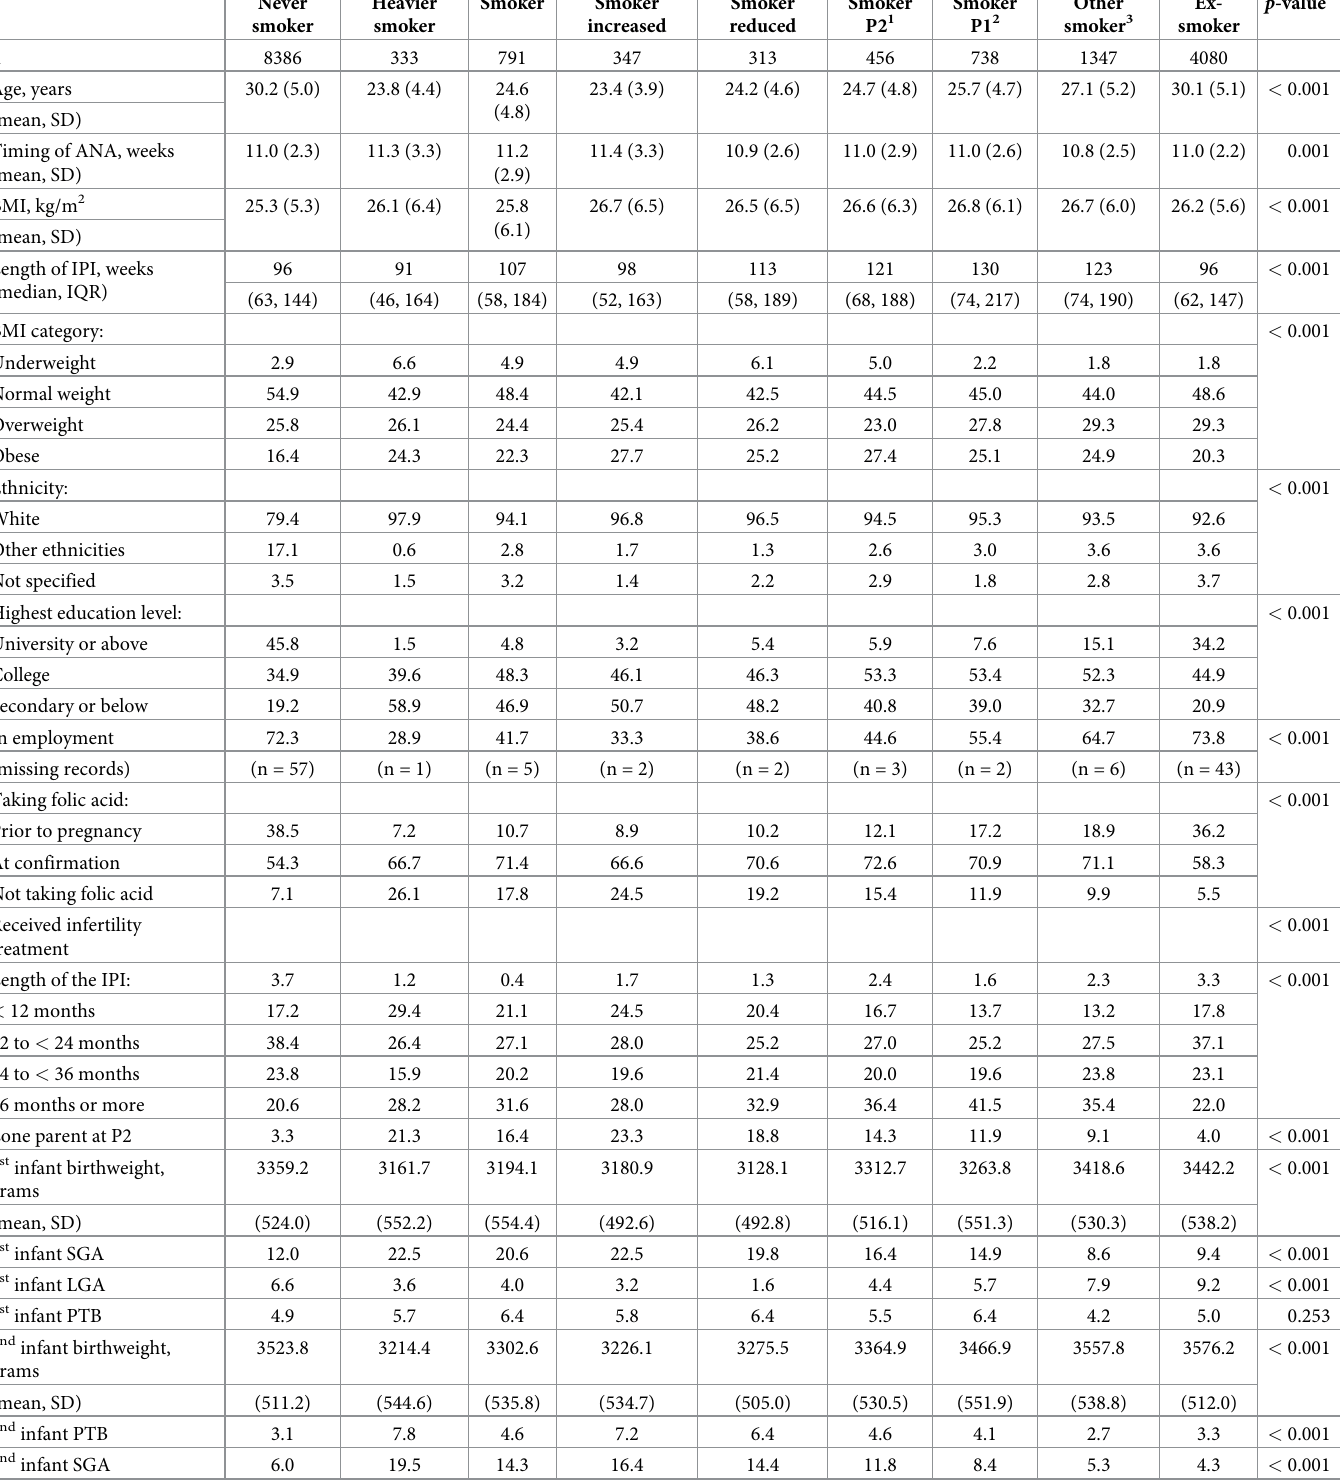
Table 2. Maternal characteristics recorded at the first antenatal appointment at the start of the second pregnancy, together with characteristics of both the first and second